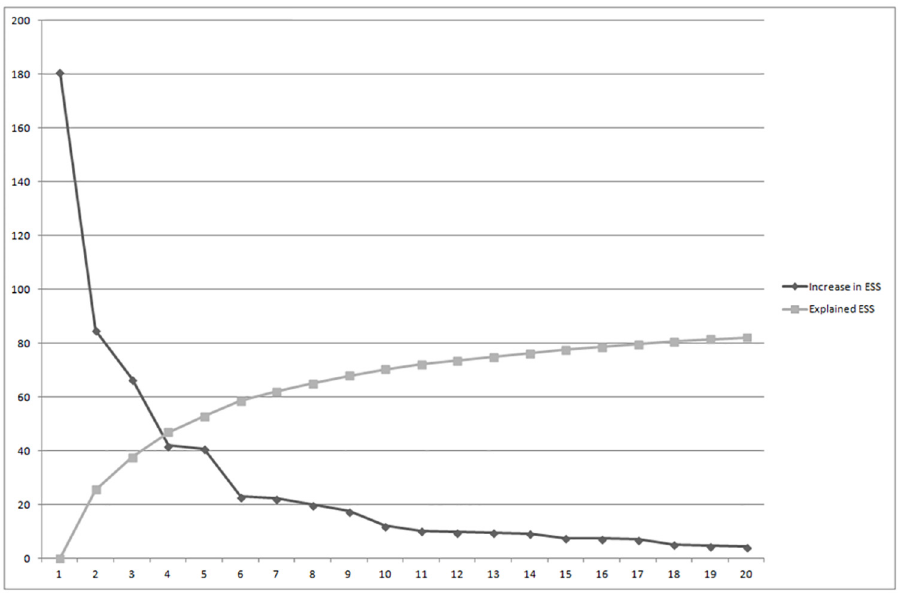
Fig 1. Error sum of square plot for the activity cluster solution. ESS = error sum of